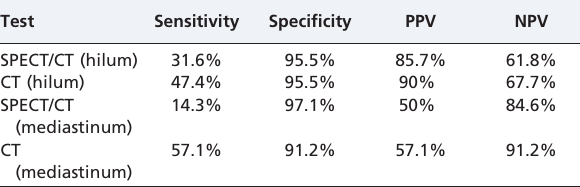
Table 2 - SPECT/CT and CT results for the analyses of the hilar and mediastinal lymph nodes.